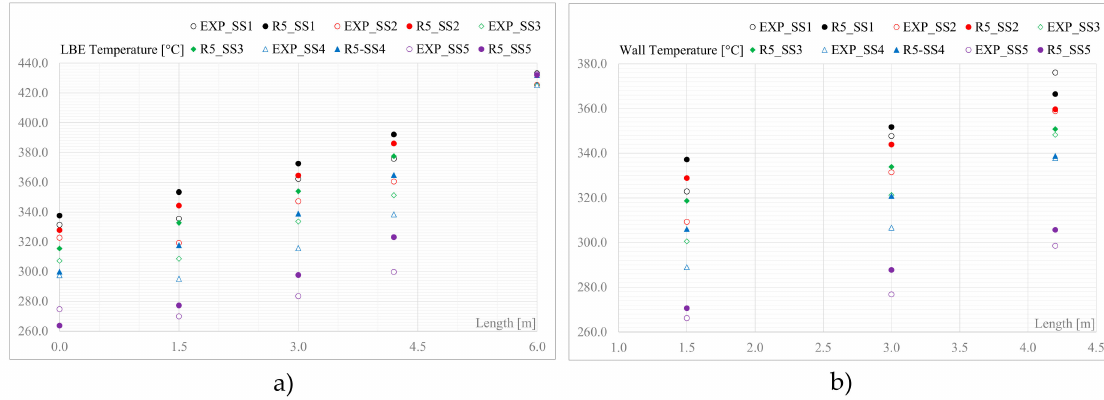
Figure 14. EF-T4, exp. vs. RELAP5-3D: ( a ) SG LBE bulk temperatures; ( b ) wall temperatures.